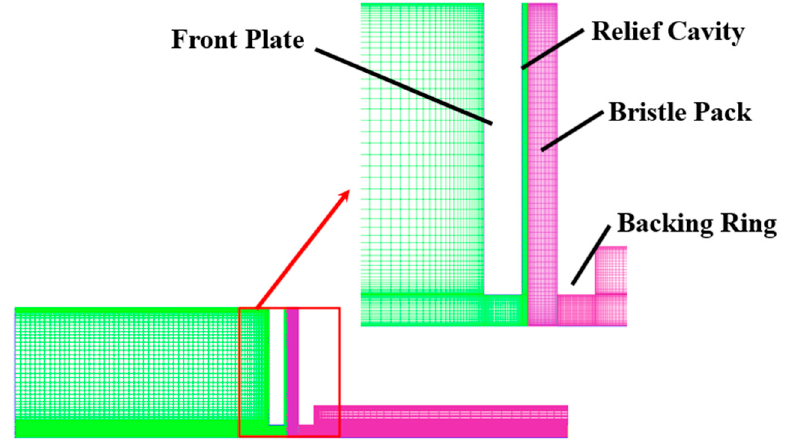
Figure 5. Mesh generation.